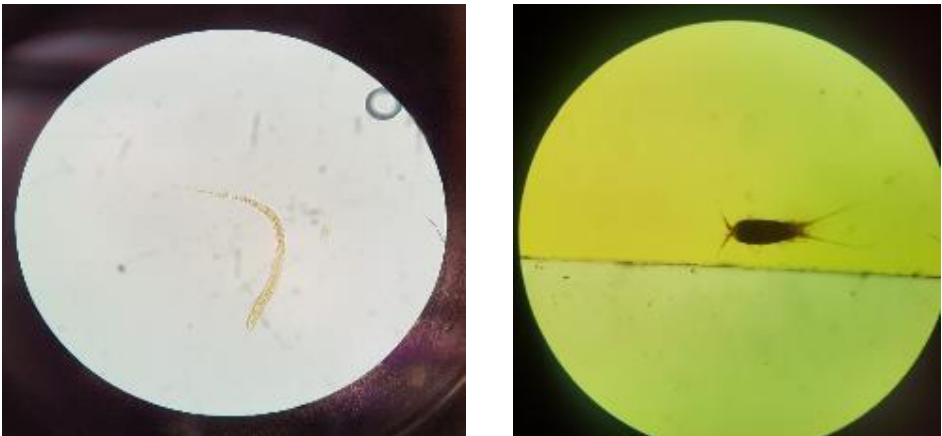
Figure 2. ( Left ) parasitic nematodes ( Nematodirus sp.) at SG1 examined under a microscope using 10 × Figure 2. Left , parasitic nematodes (Nematodirus sp.) at SG1 examined under a microscope using 10  magnification; ( right ) copepod at SG2 examined under a microscope using 10 × magnification; right , copepod at SG2 examined under a microscope using 10  magnification .